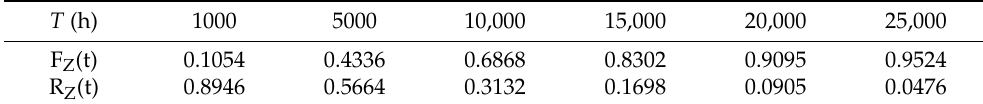
Table 2. Probability of failure and reliability of automotive airbag systems. T